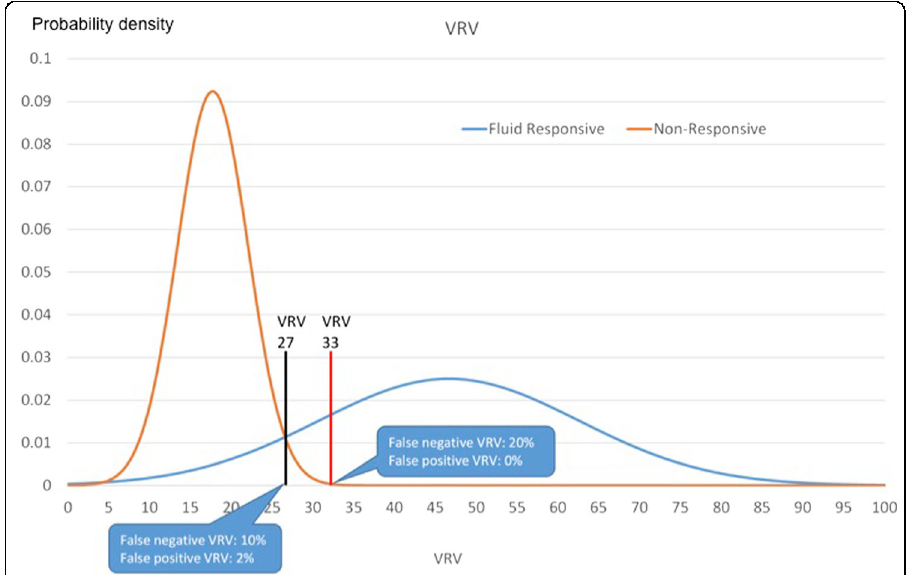
Fig. 4 The curves of VRV indexes for volume responders and volume non-responders. VRV venous return variation